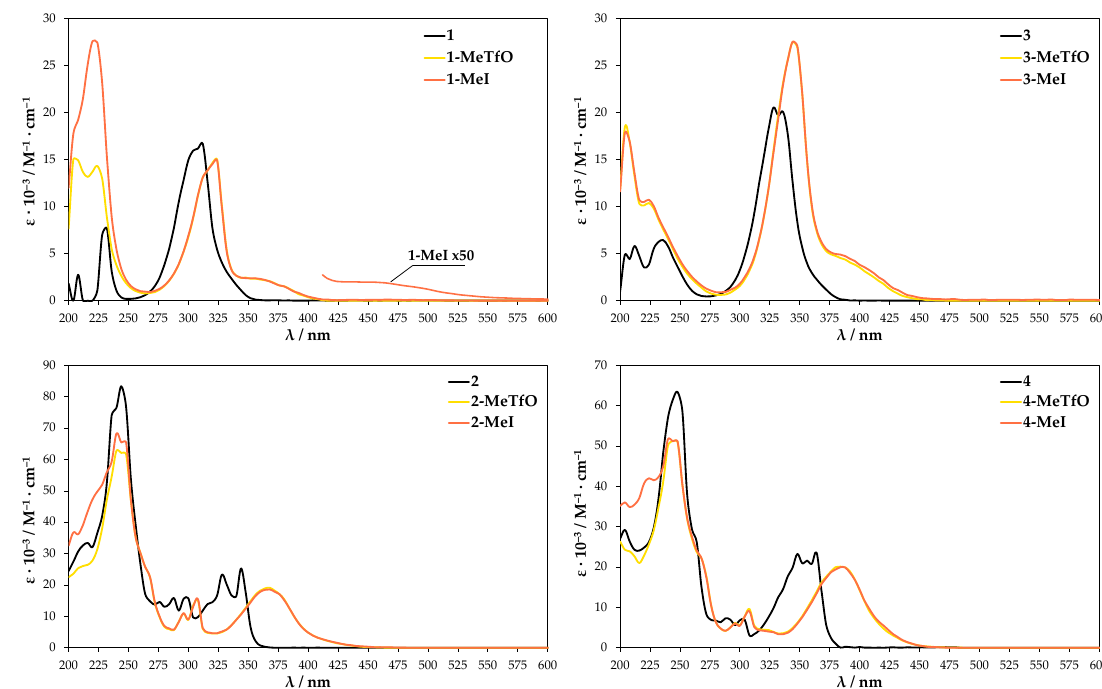
Figure 8. UV ‐ Vis spectra of the compounds dissolved in methanol. Figure 8. UV-Vis spectra of the compounds dissolved in